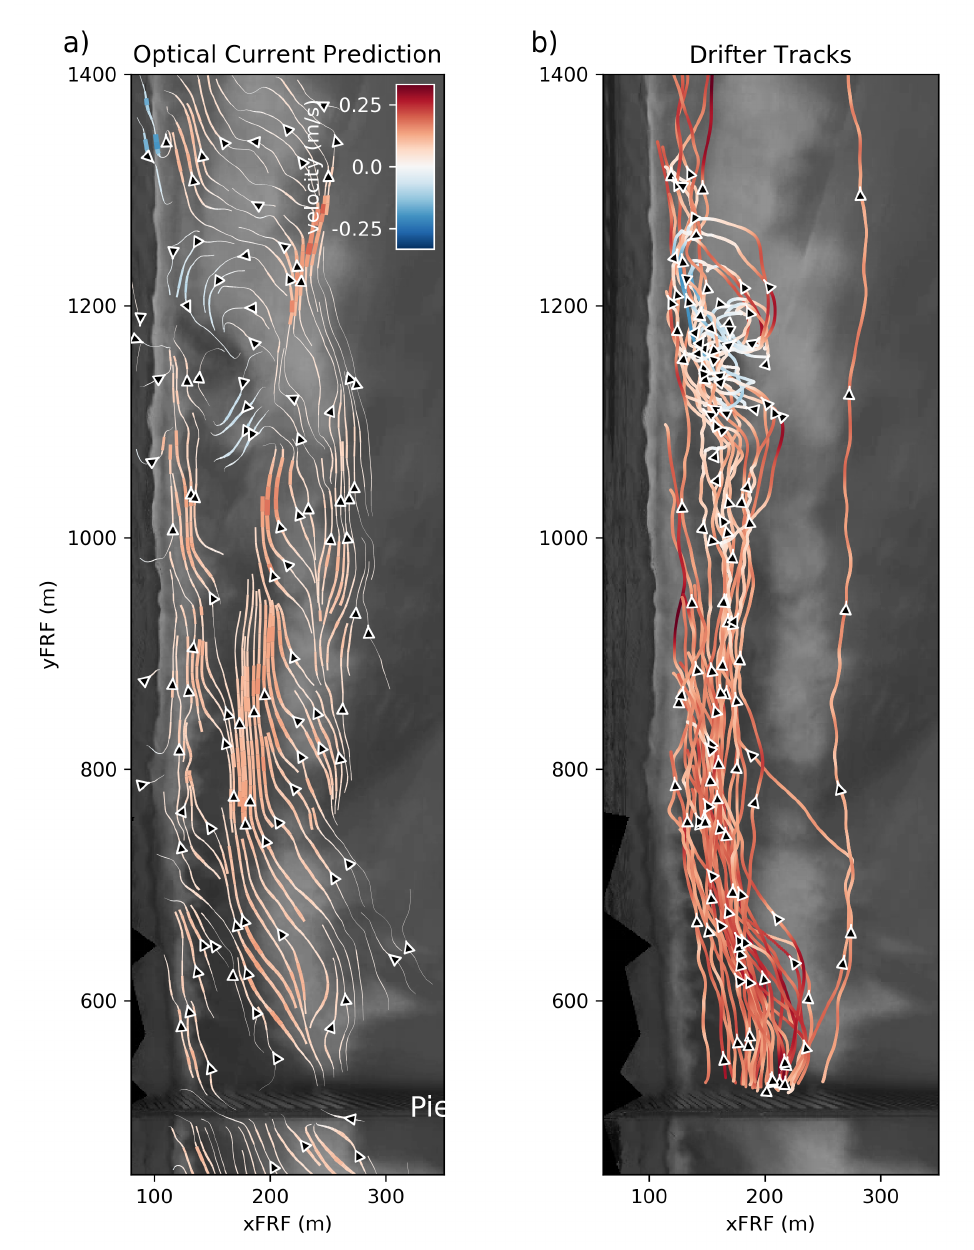
Figure 7. Analogous to Figure 5, a comparison of spatial currents derived from ( a ) optical flow applied to a wave-averaged movie and ( b ) a drifter deployment on 31 October 2019 at